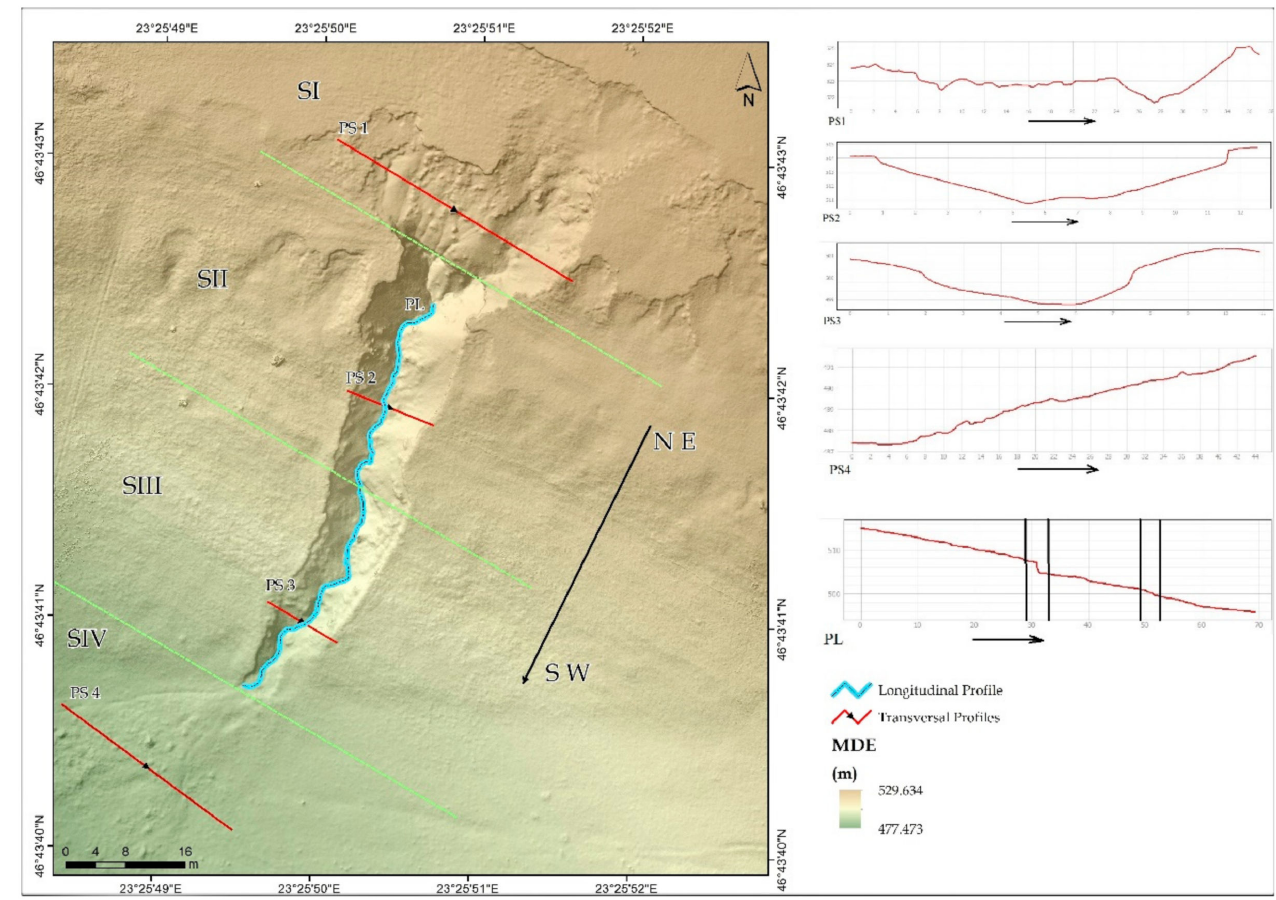
Figure 6. Morphometric characteristics of the